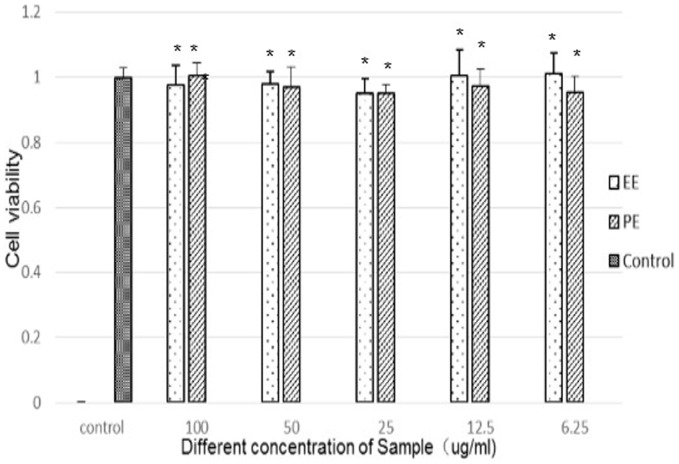
Cytotoxic effect of extracts on RAW264.7 murine macrophage cells.After the cells were incubated with the EE and PE fraction (0, 6.25, 12.5, 25, 50, 75, and 100 ug/mL) for 24 h, the viability was measured by MTT assay. * Drug group compared with control group, both P values >0.05;